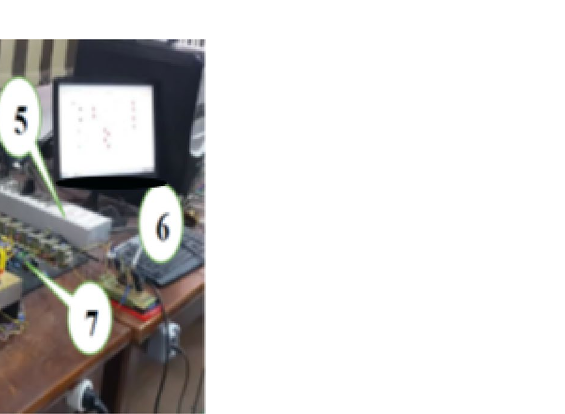
Figure 12. Response to a successive change in the reference voltage, AC–DC. ( a ) Input/output voltages, ( b ) inductor and load currents.